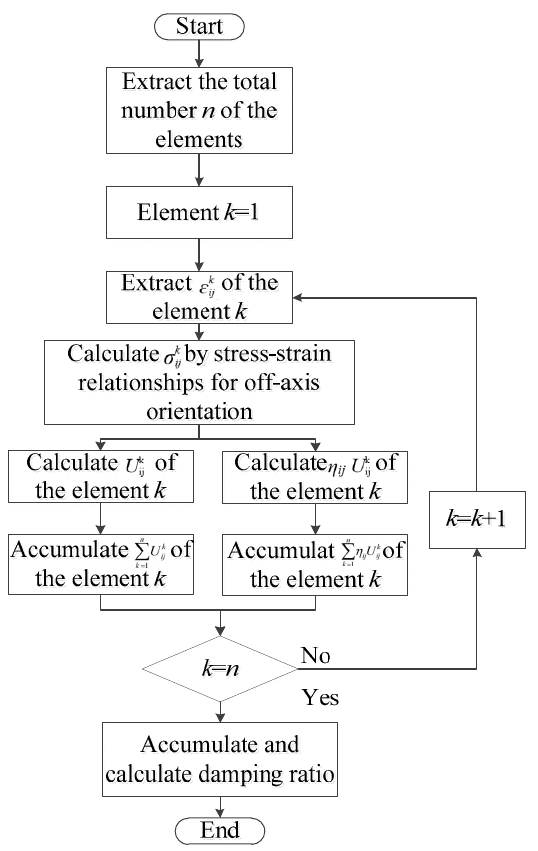
Figure 2. Process of the damping ratio calculation.